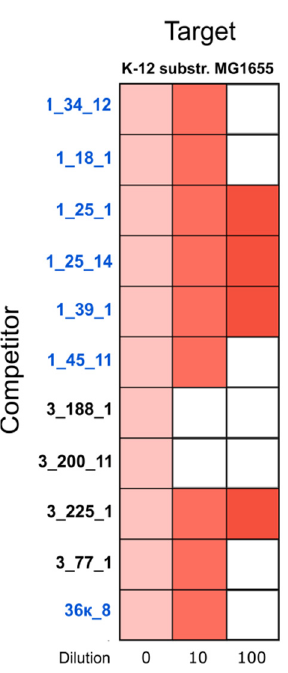
Figure 3. The antagonistic activity of E. coli strains from the gut against the strain K-12 substr. MG1655. Strains of healthy individuals are marked in blue. Red color indicates halo zone formation, white color—no halo. Deeper red corresponds to the lower concentration of the competitor strain.